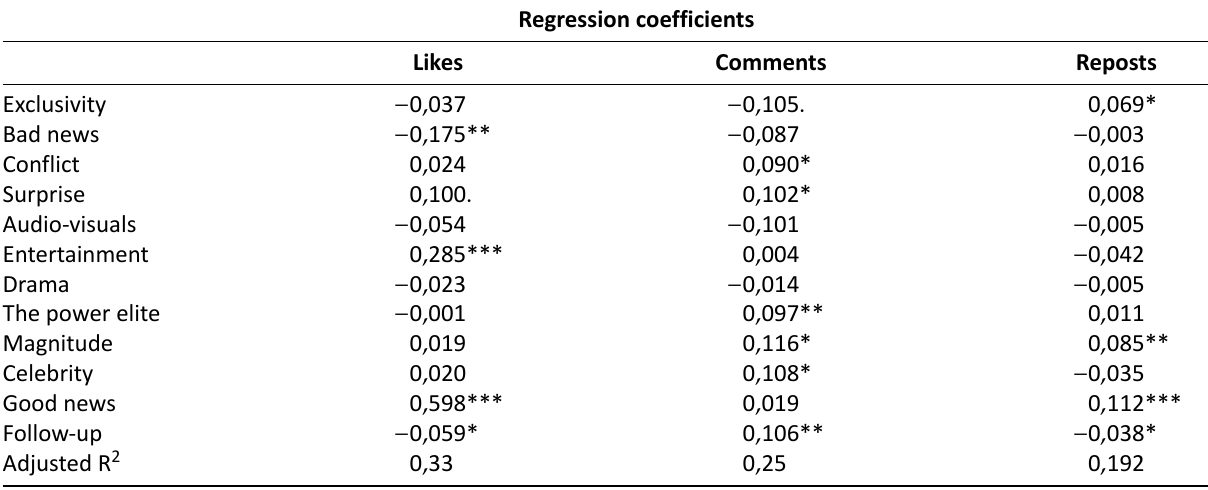
Table 2. Multiple regression models testing news values for likes, reposts and comments: All cases. Regression